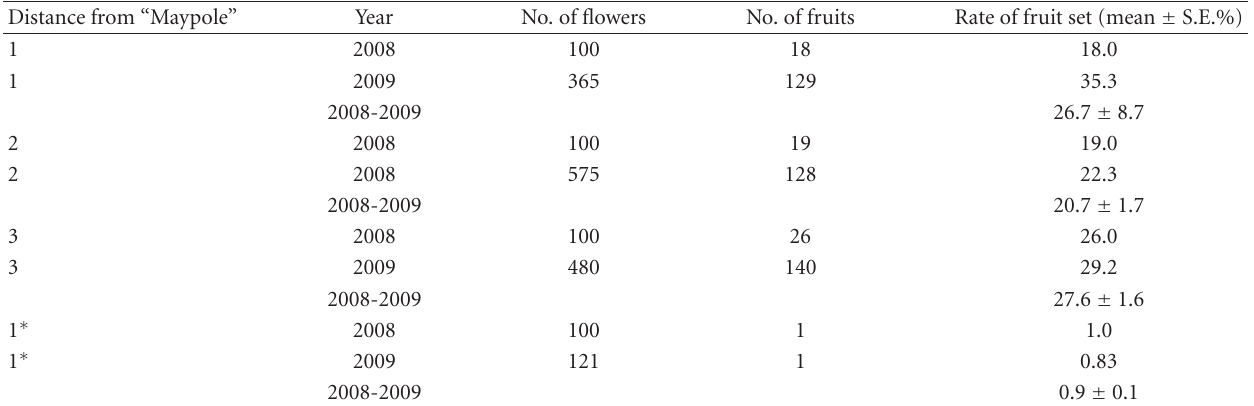
Table 3: Fruit set of “Alps-Otome” fruit formed by “Maypole” pollen carried by Osmia cornifrons